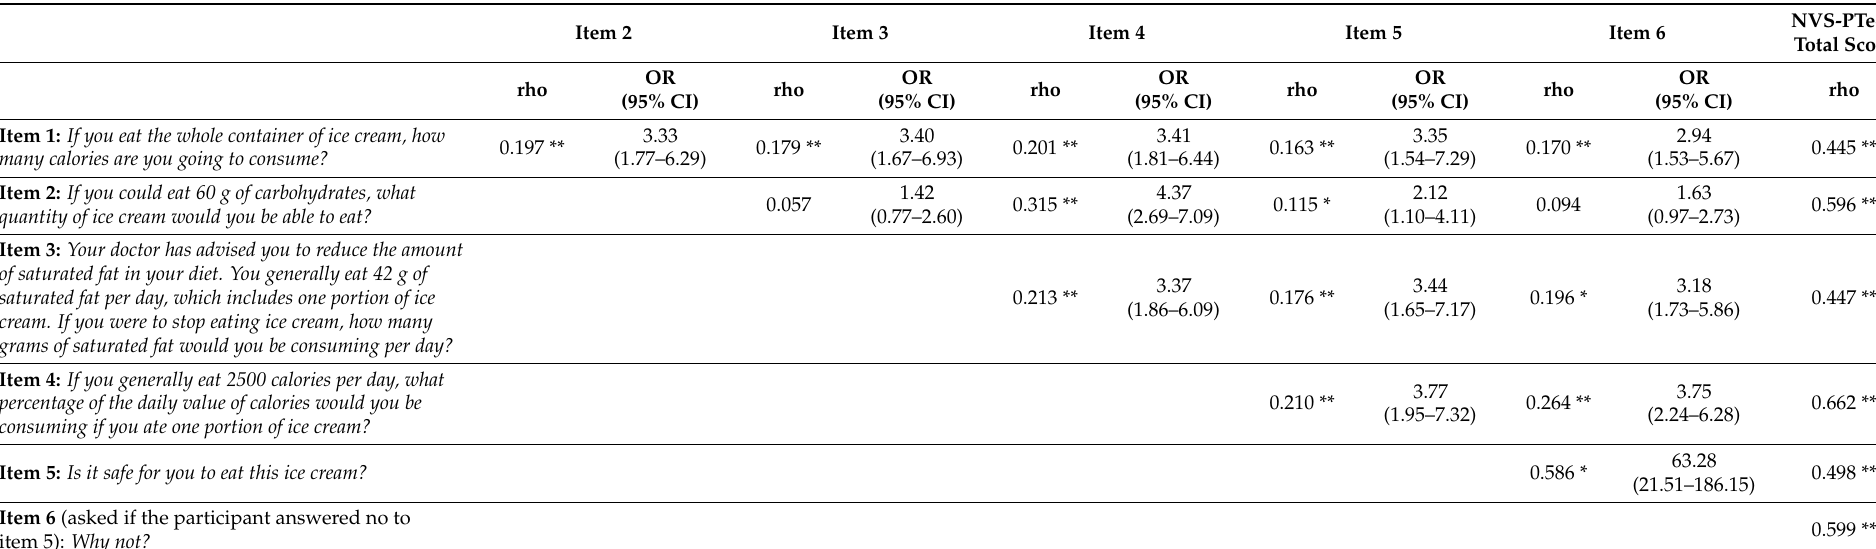
Table 3. Inter-item and item-total NVS-PTeen scores (Spearman’s rank correlation coefficients matrix and inter-item pairwise odds ratio (OR) with 95% confidence intervals (95% CI); N =